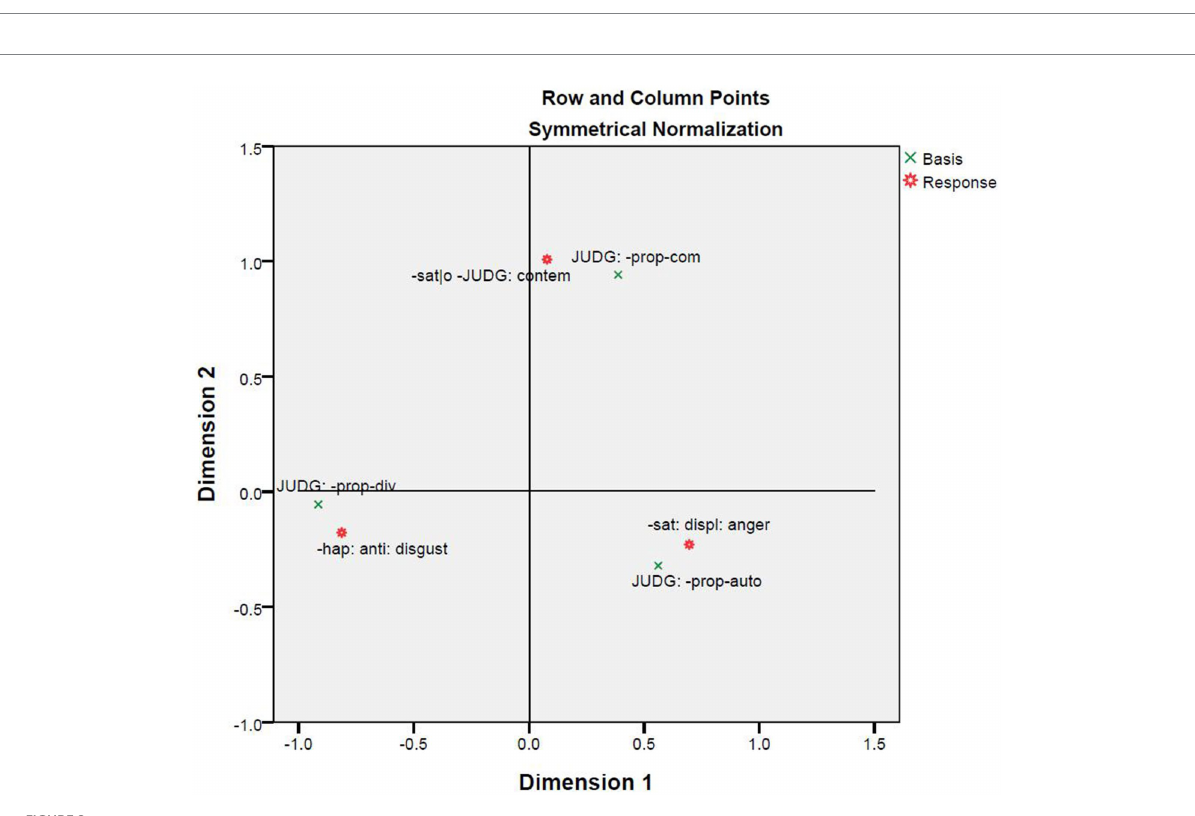
FIGURE 7 Correspondence analysis between basis and situation.